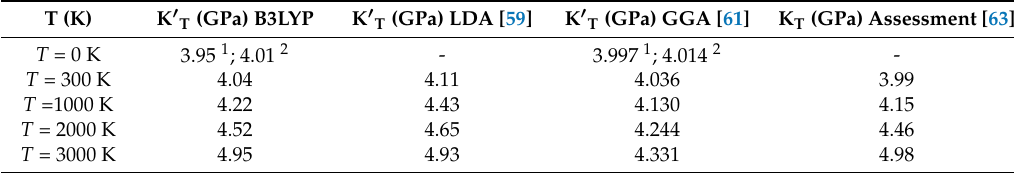
Table 2. Ab initio B3LYP temperature dependence of the isothermal bulk modulus pressure derivative (K ′ T ) of MgO. Values obtained in this work are compared to other ab initio simulations at LDA [59] and GGA [61] level of theory and thermodynamic assessment [63].